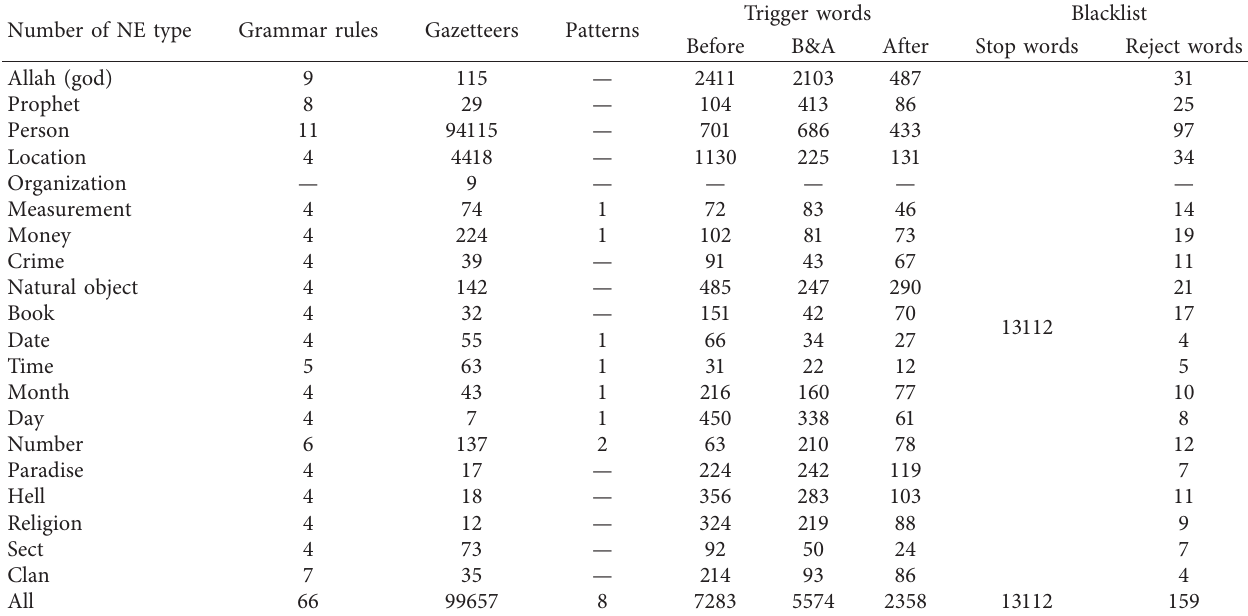
Table 2: Data Resource.